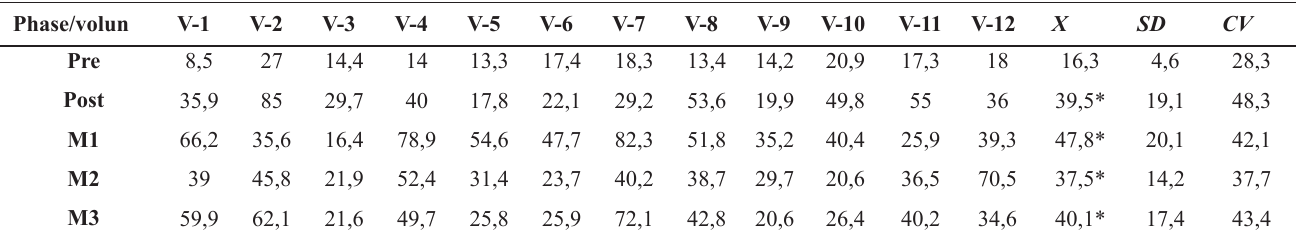
Table 3. Creatine kinase (CK) expressed in values relative (%) to the maximum concentration of CK-U/L during a competitive soccer season Phase/volun